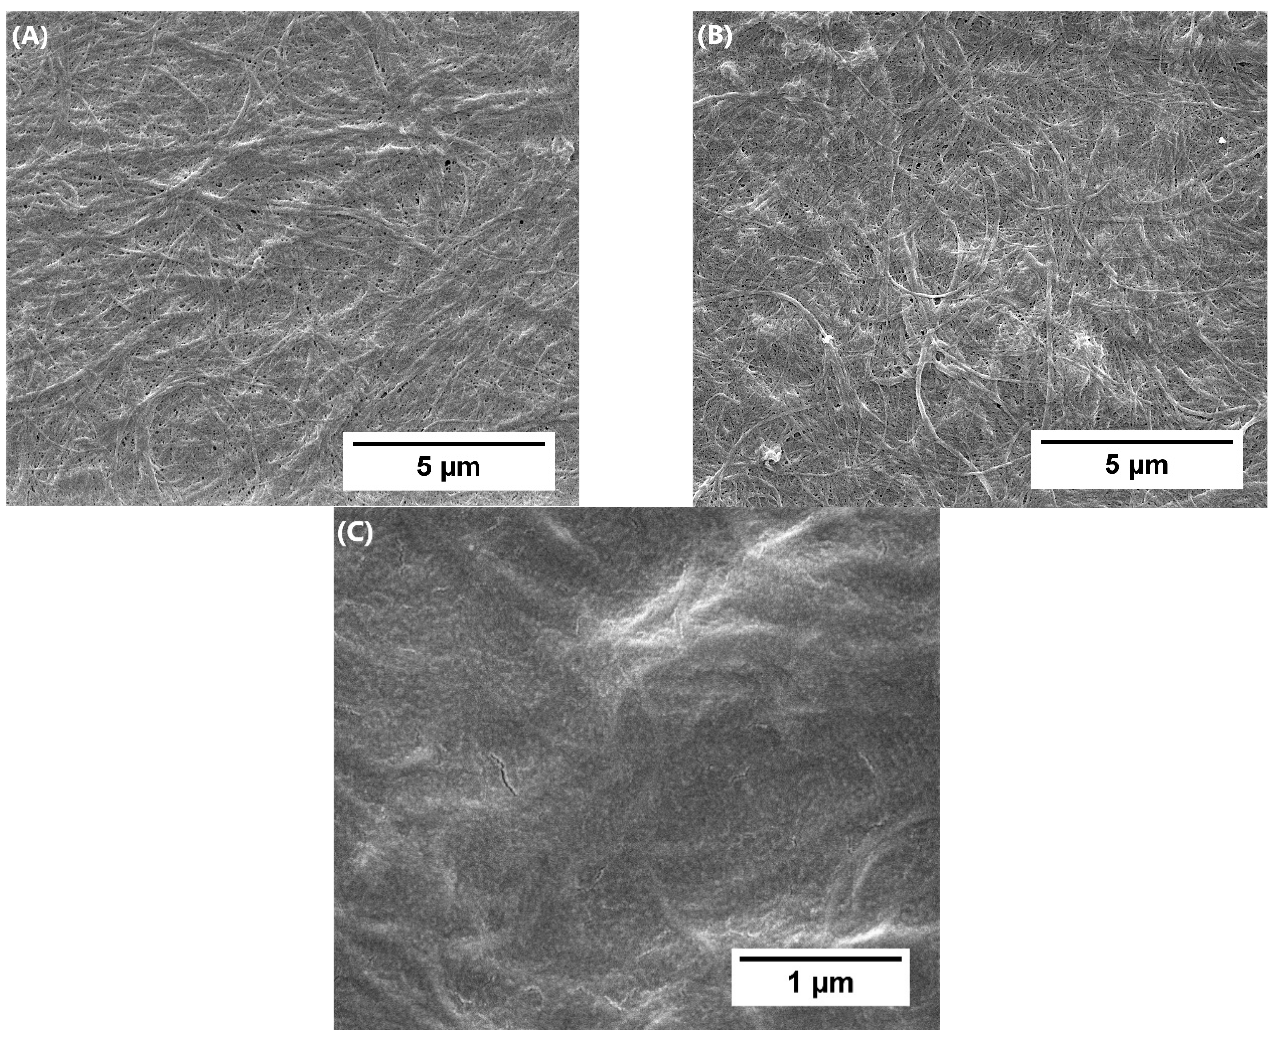
Figure 5. FE-SEM images of ( A ) CNF, ( B ) CNF-based macroinitiator and ( C ) CNF-PSA .